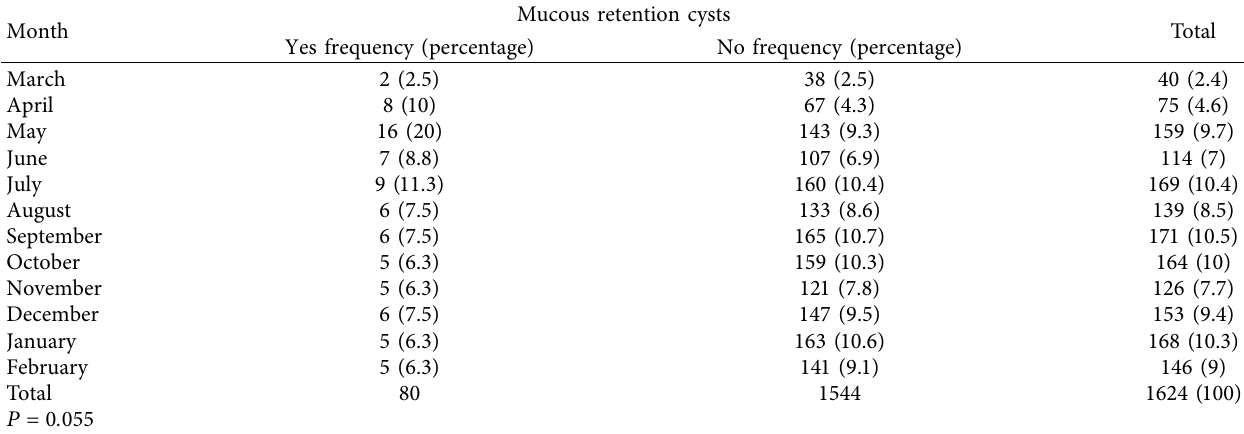
Table 6: The frequency of mucous retention cysts (MRCs) in the population was studied following the first months of the